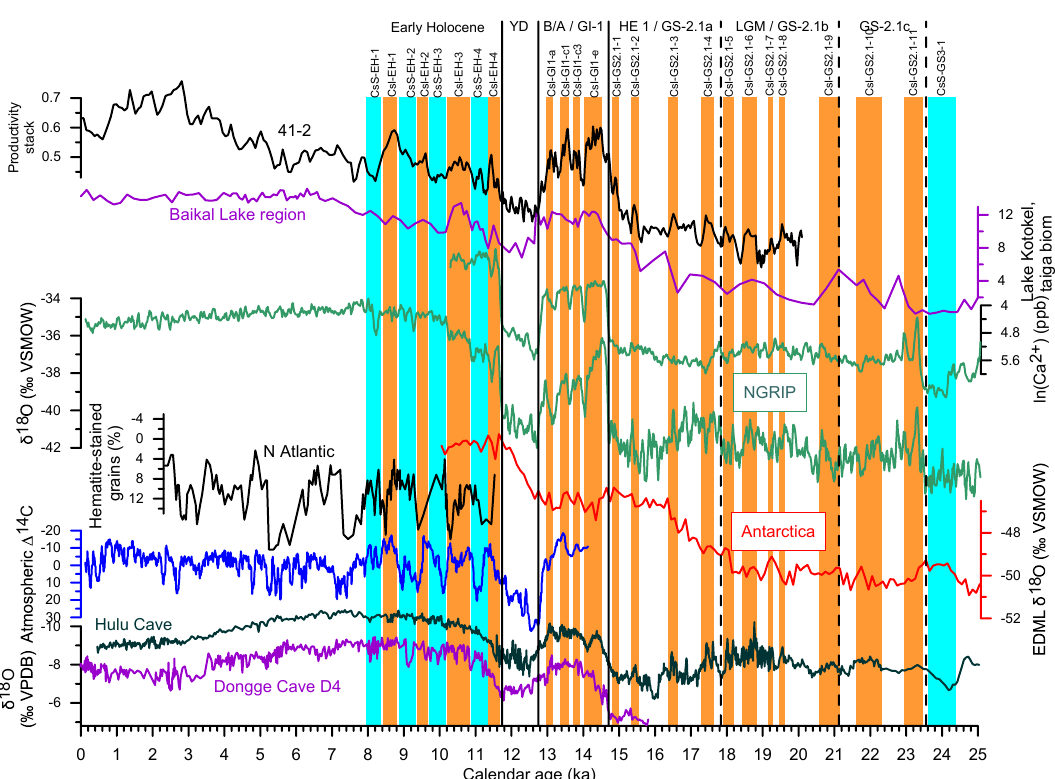
Figure 5. Compilations of Northern and Southern Hemisphere climate records, solar activity, NW Pacific productivity events, and vegetation records from southern Siberia during the last 25kyr. From bottom to top: absolute-dated δ 18 O calcite of Chinese cave stalagmites (Dykoski et al., 2005; Wang et al., 2008), the residual atmospheric (cid:49) 14 C record of around 2000-year moving average (Reimer et al., 2004), δ 18 O EDML records after methane synchronization with the N Greenland ice core (EPICA Community Members, 2006), the petrologic tracer of drift ice in the N Atlantic (Bond et al., 2001), the δ 18 O and Ca 2 + records in the Greenland NGRIP ice core indicated air temperature and dust variability on GICC05 age scale (Rasmussen et al., 2014), pollen-reconstructed southern Siberia environment changes (Lake Baikal region) (Bezrukova et al., 2010) and productivity stack for core 41-2. Orange and blue bars are as in Fig. 2. Centennial events with increased productivity are associated with sub-interstadial of the EASM and with increasing input of solar irradiance during the LGM-B/A and EH short-term warmings, respectively. The correlation between short-term increased Greenland temperature (NGRIP ice core) and a decreased Antarctic temperature is less pronounced but seems to be marked as